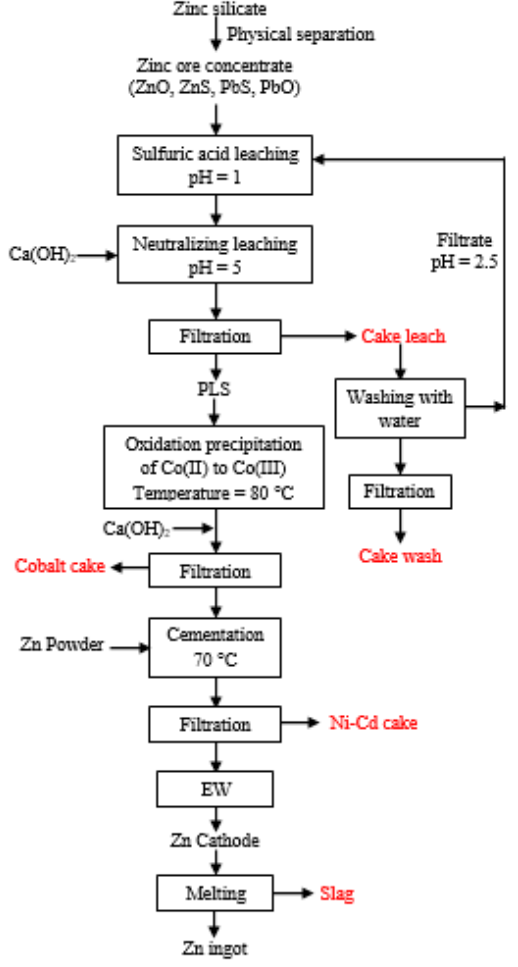
Figure 1. General flowsheet of ziterite process by hydrometallurgical route. Table 1. Chemical analyses of zinc process residues in % (weight).